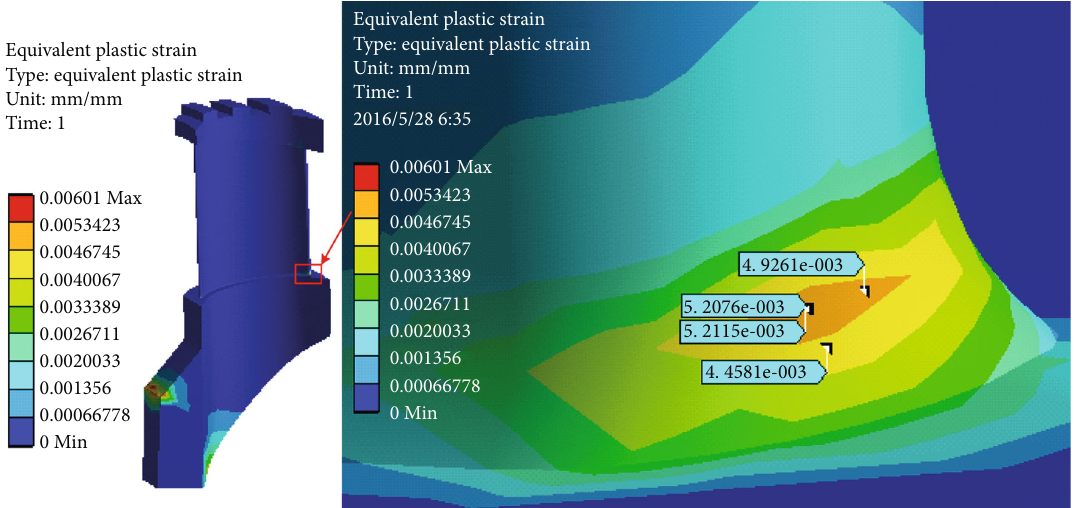
Figure 16: Equivalent plastic strains on the blade surface.